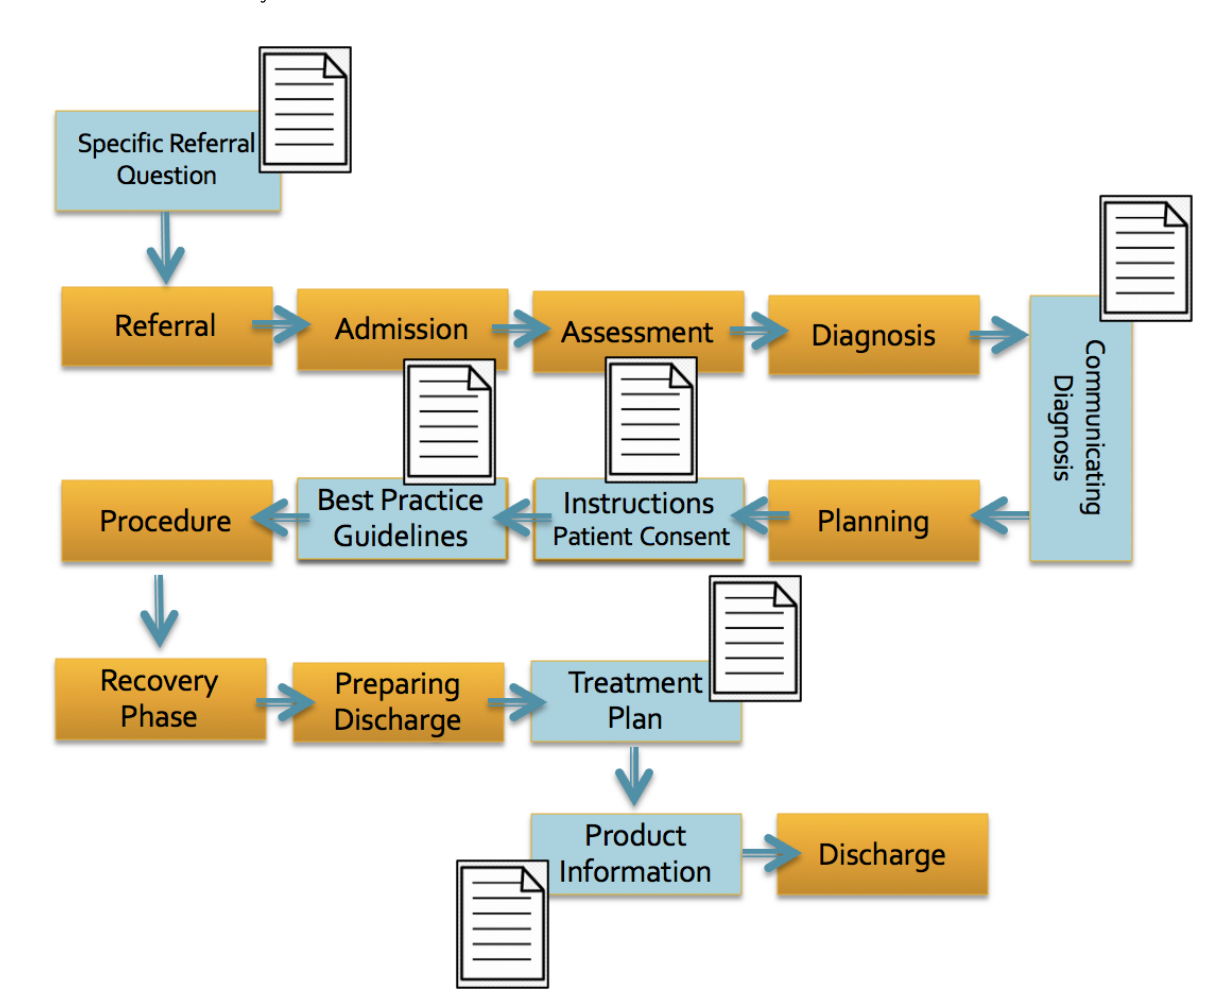
Figure 1. There are multiple steps in the successful delivery of health care with critical phases, where clearly written and easy-to-understand communication documents are